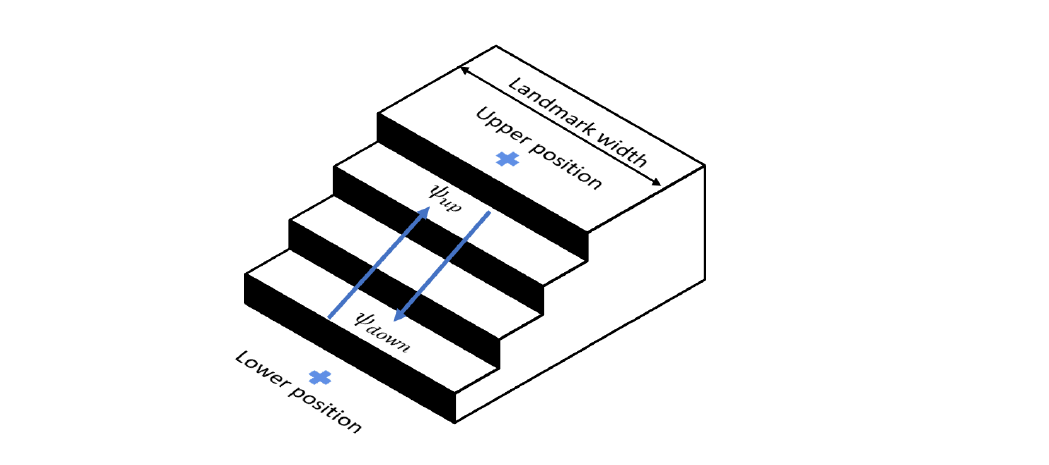
Figure 16. Example of the upper and lower parts of a landmark in an underground station. Table 1. Example of two landmarks stored in the database.